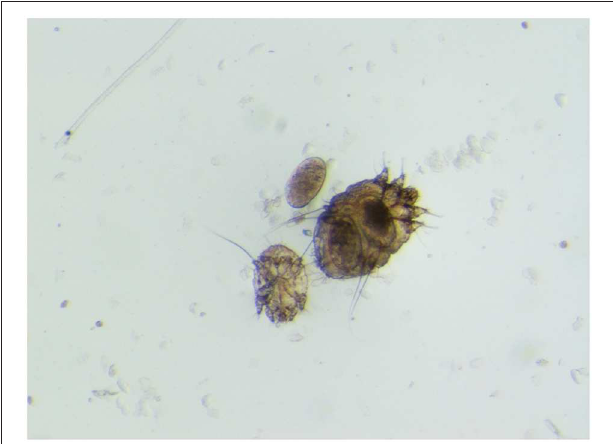
FIGURE 1 | Sarcoptes scabiei var. rupicaprae (stereomicroscope 60 × ) from a mangy northern chamois ( Rupicapra r. rupicapra ) in northeast Italy.